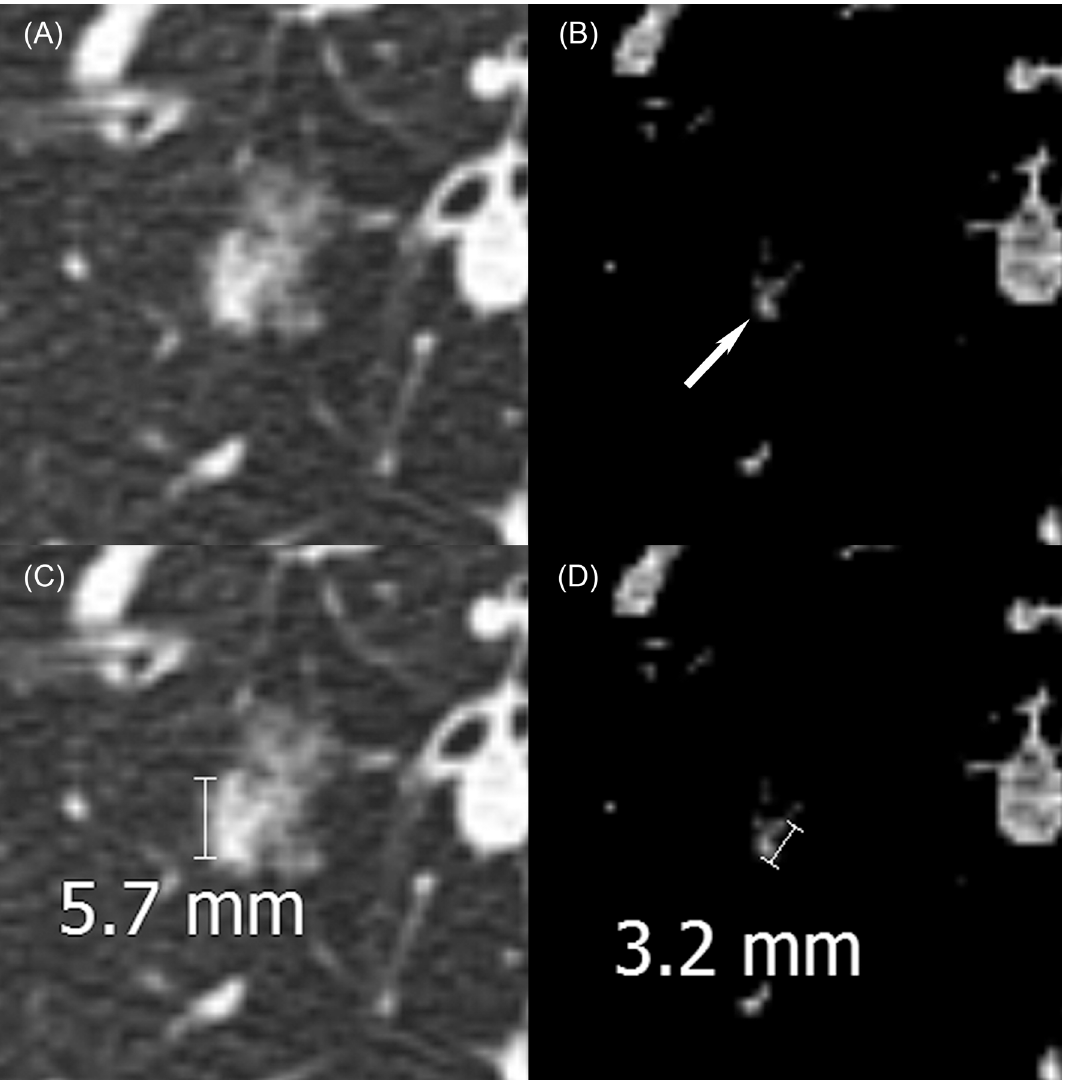
Fig 2. A 55 year-old female with a part-solid nodule in the right lower lobe of the lung. The internal solid portion was identified on both (A) lung window and (B) mediastinal window settings (arrow). Measurement differences between scans on replaced reader follow-up ranged (C) from -3.3 to 0.2 mm on lung window and (D) from -2.0 to 0.5 mm on mediastinal